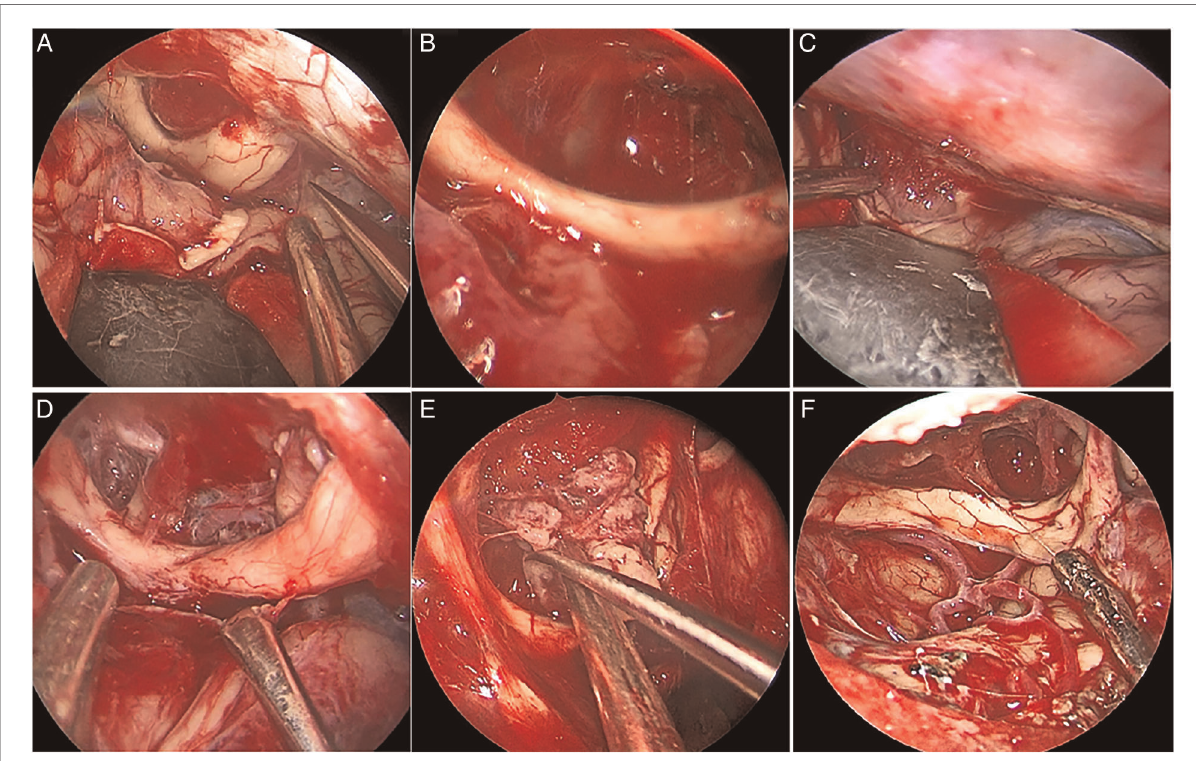
FIGURE 4 Intraoperative optic neural tube invasion ( A ) Under the optic nerve on the right side of the tumor and in the fi rst space, push the optic nerve upward; ( B ) After total resection of the tumor ( C ) the main body of the tumor is located in the fi rst space, and the right optic nerve is pushed upward and outward; ( D ) After total resection of the